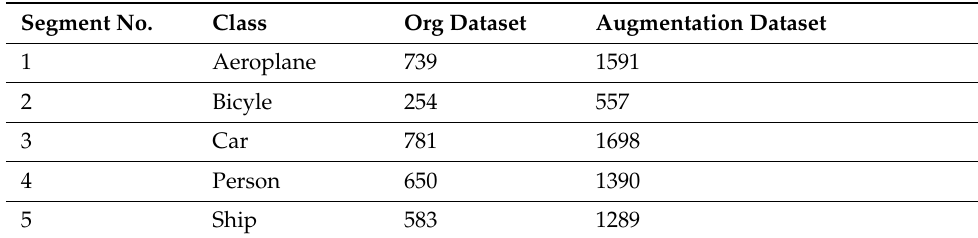
Table 1. Amount of original and augmentation data by target type.